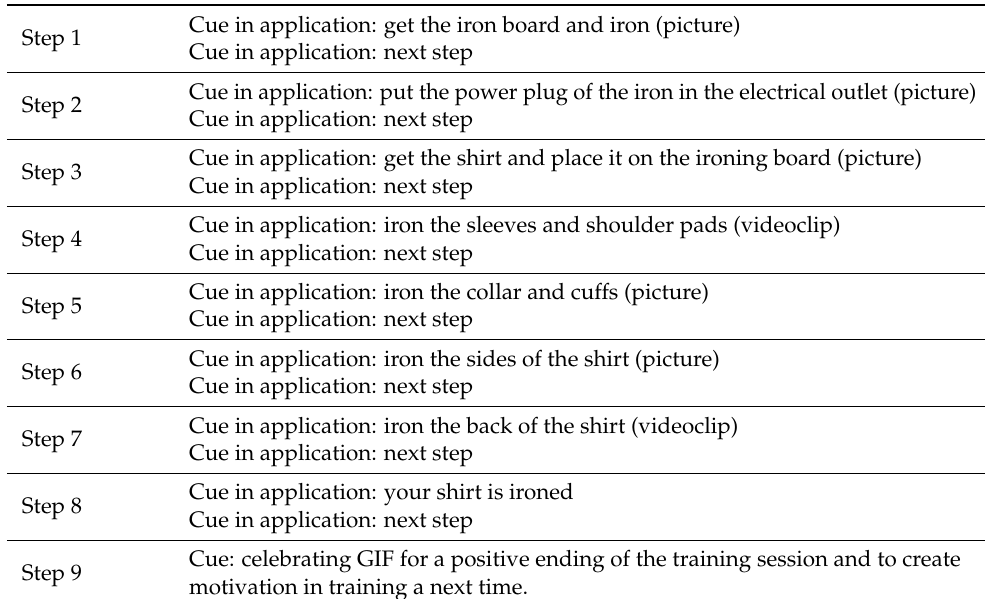
Table 2. Errorless learning plan for